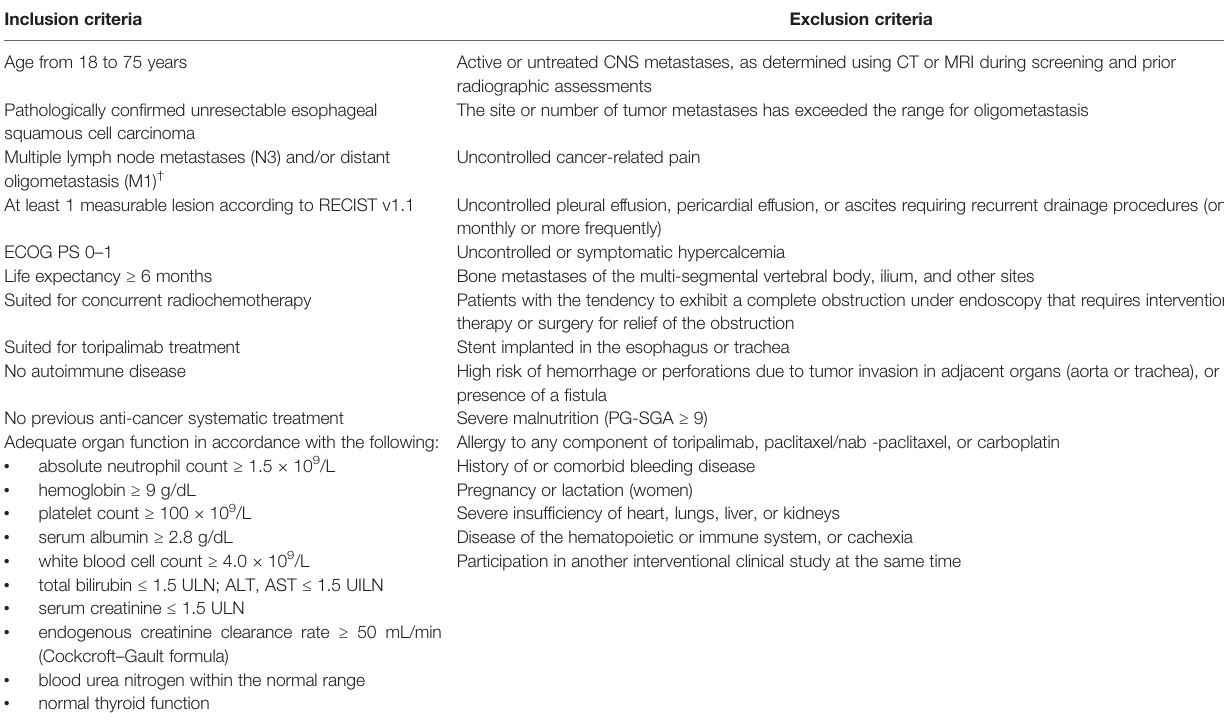
TABLE 1 | Key eligibility criteria for this